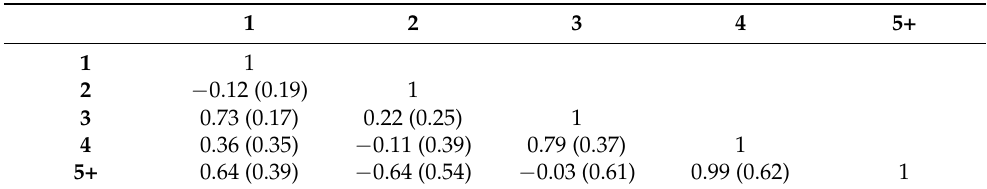
Table 8. Correlation matrix for days to calving with genetic correlation below for each joining number with standard error in